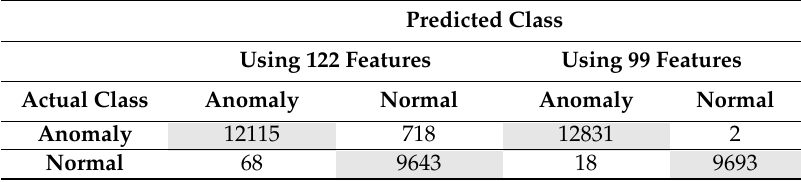
Table 14. The confusion matrices of binary classification on KDDTest + (122 features vs. 99